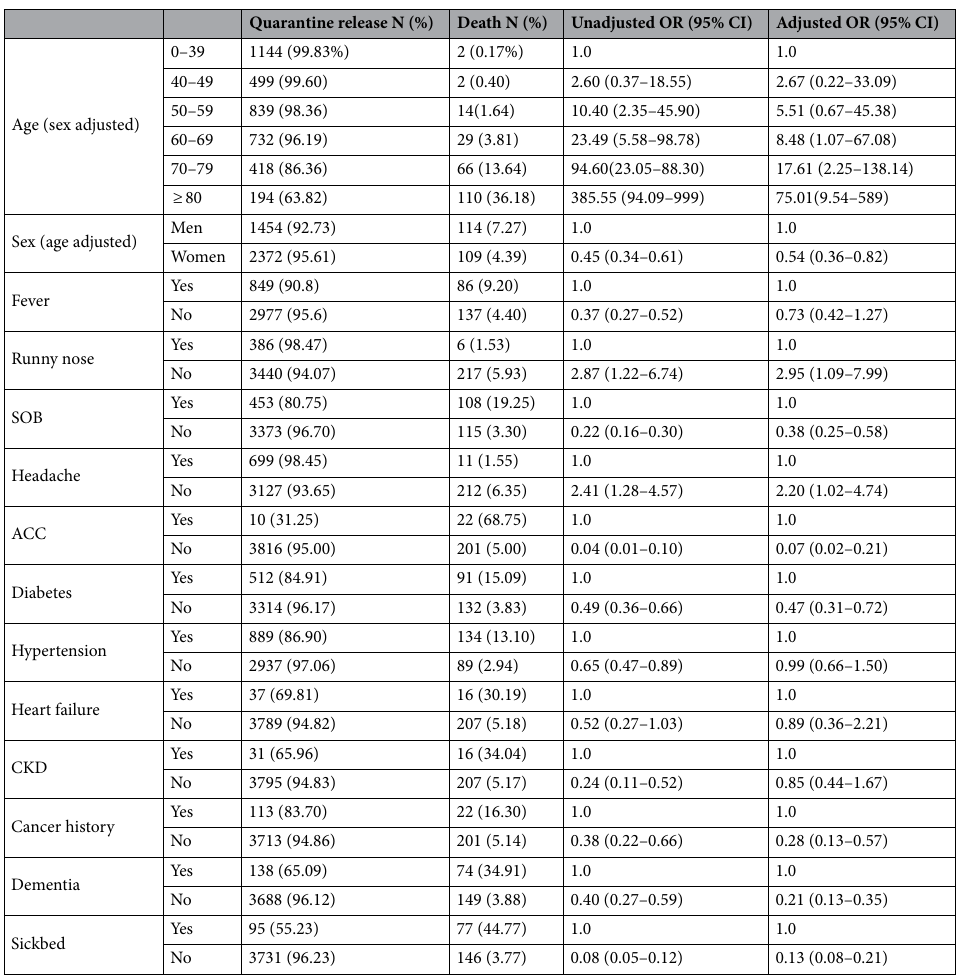
Table 1. Clinical and epidemiological characteristics of COVID-19 confirmed patients according to outcome status: categorical variable. SOB shortness of breath, ACC Abnormal change of consciousness, CKD chronic kidney